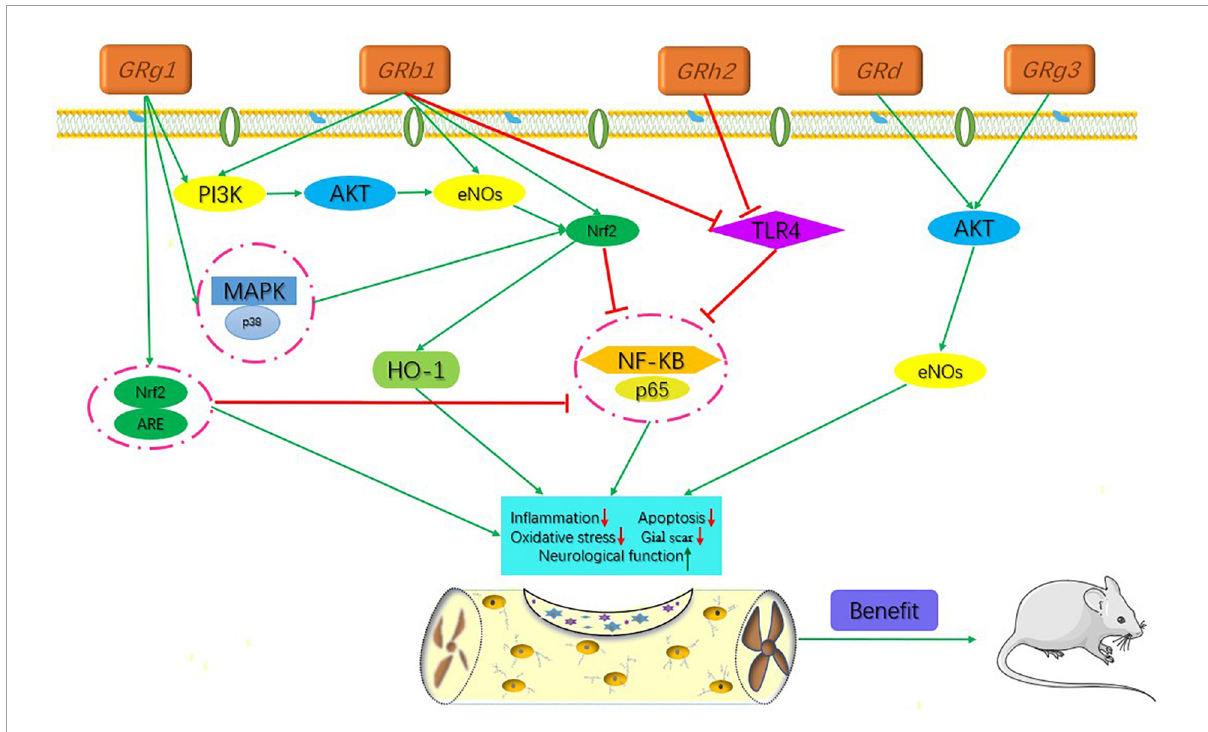
FIGURE1 Signaling pathways of the different kinds of ginsenosides in the treatment of spinal cord injury.